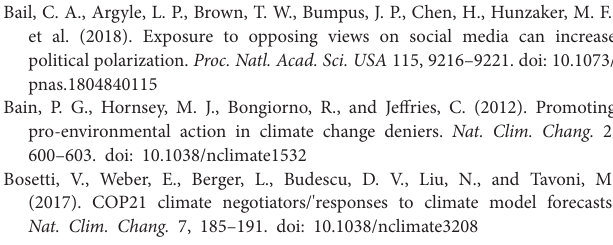
FIGURE S2 | A heatmap showing the distribution of the average density of mouse location on the graph for independents ( N = 11). Participants whose ratings on the political orientation scale were 0 were grouped as liberals and whose ratings on the political orientation scale were above 0 were grouped as conservatives. Warmer colors represent higher average density of mouse